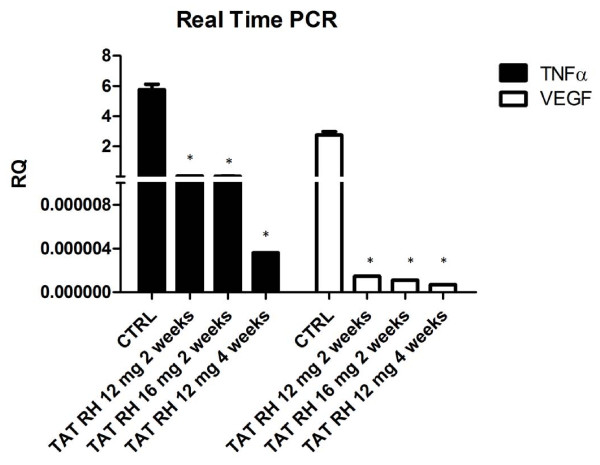
Real-Time PCR analysis of inflammation and angiogenesis in TAT-RH treated tumors. VEGF and TNFα expression was evaluated by Real Time PCR to assess the ability of TAT-RH to inhibit NFκB-dependent gene expression in cancer cells. At 2 weeks from starting treatment VEGF and TNFα expression is strongly inhibited in a dose dependent manner and prolonged treatments (4 weeks) increase such effect (*p < 0.05 vs control).